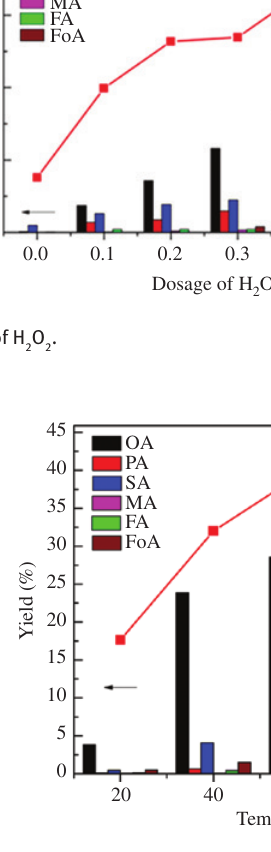
Figure 12: Effect of reaction temperature on the oxidation reaction. on the oxidation reaction. 2